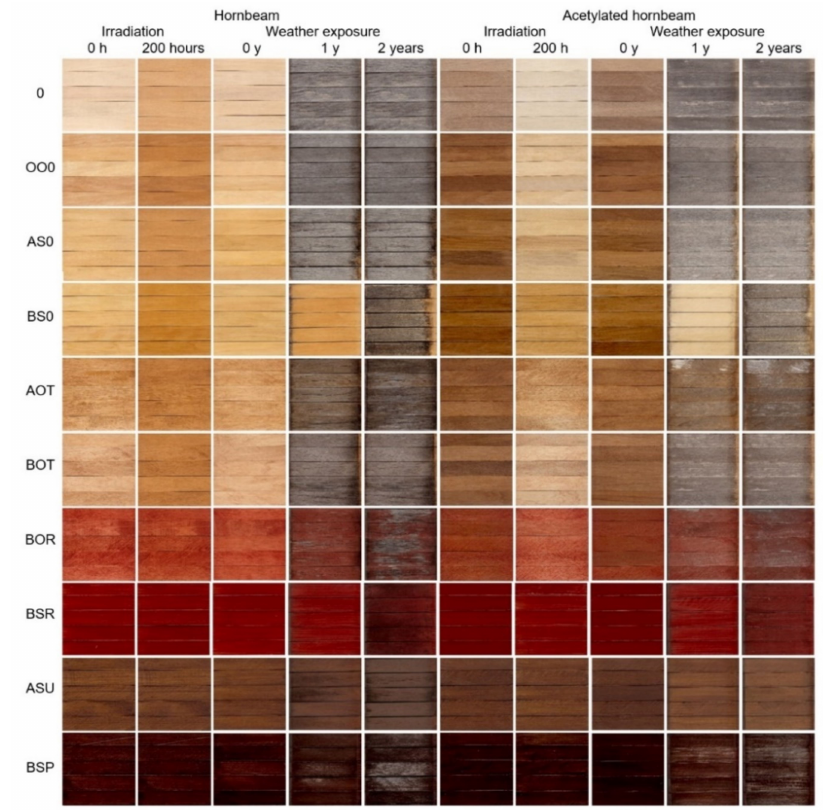
Figure 12. Scans of uncoated and coated hornbeam samples before and after 200-h-long irradiation and two-year-long weather